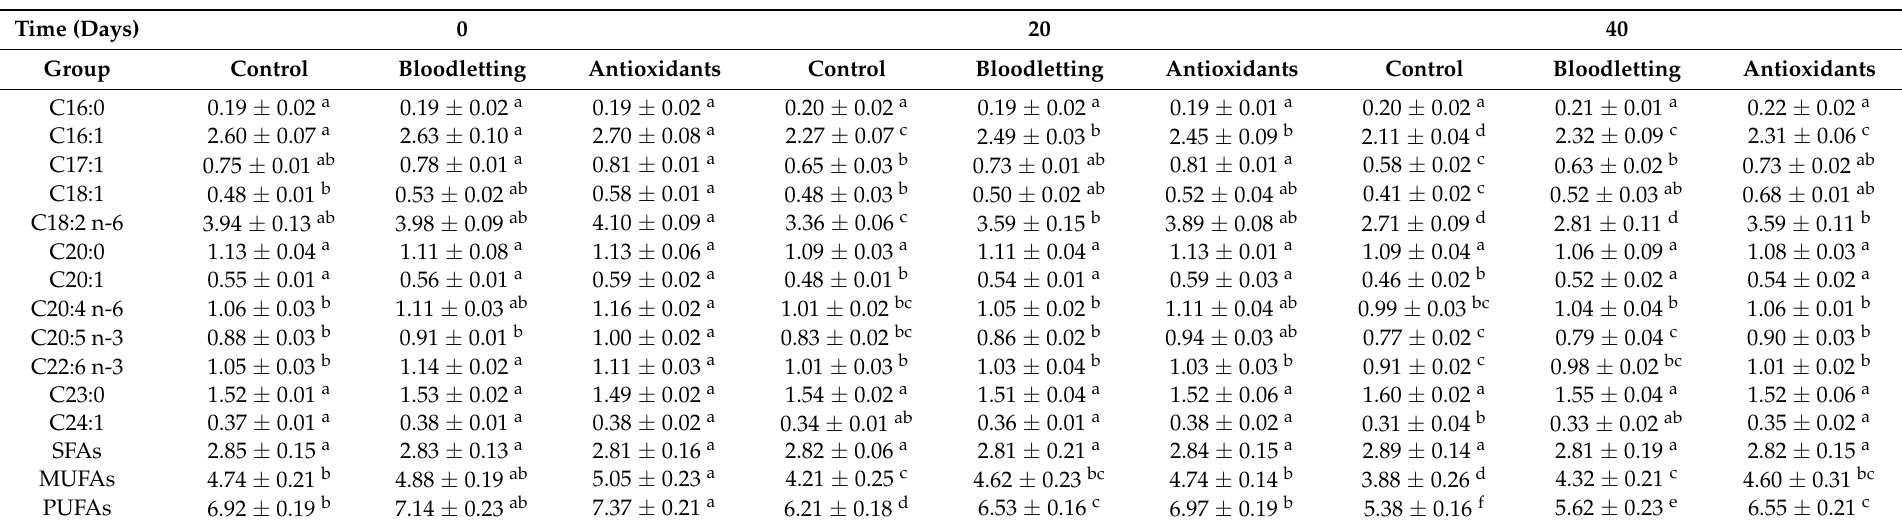
Table 2. The fatty acid composition of RTE abalone muscle during storage (mg/g of dry